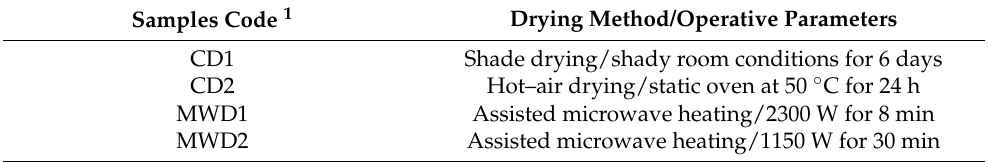
Table 1. Sample codes and notes on selected operative conditions of applied drying